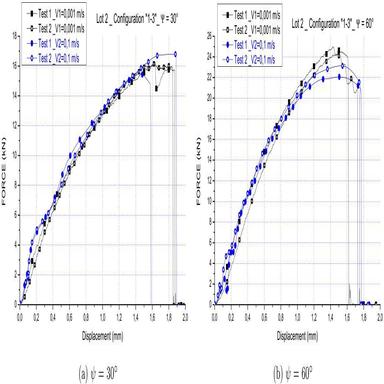
Loading velocity sensitivity under mixed modes (I/II) (a) ψ = 30∘ and (b) ψ = 60∘ .